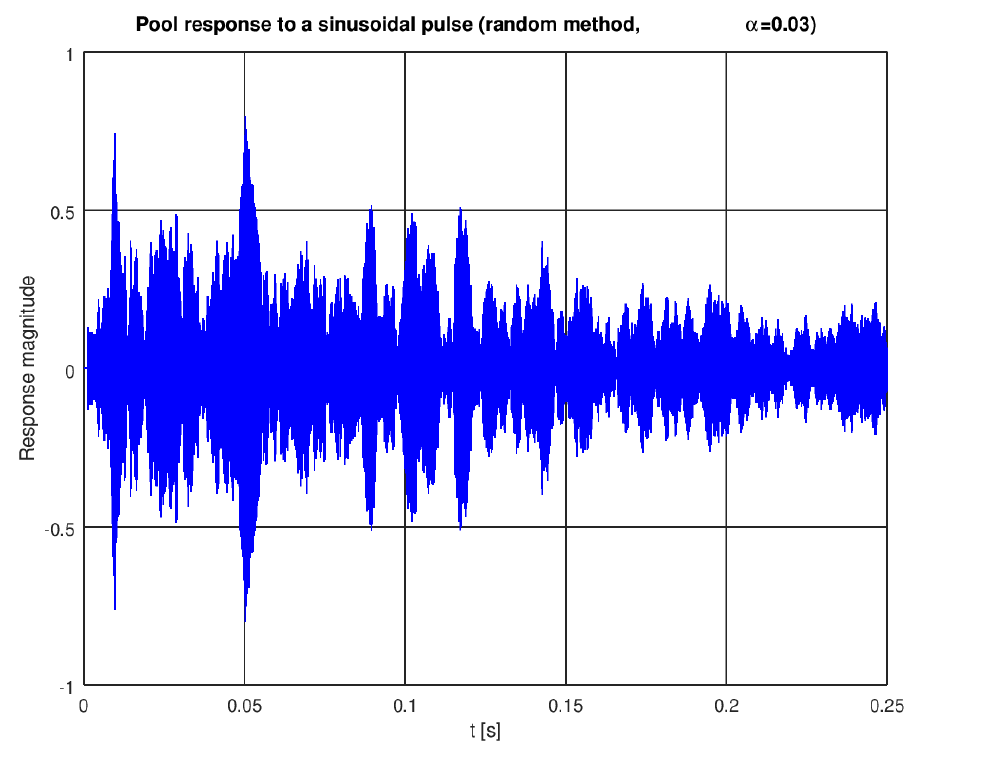
Figure 6. A response to a sinusoidal pulse with the model from Figure